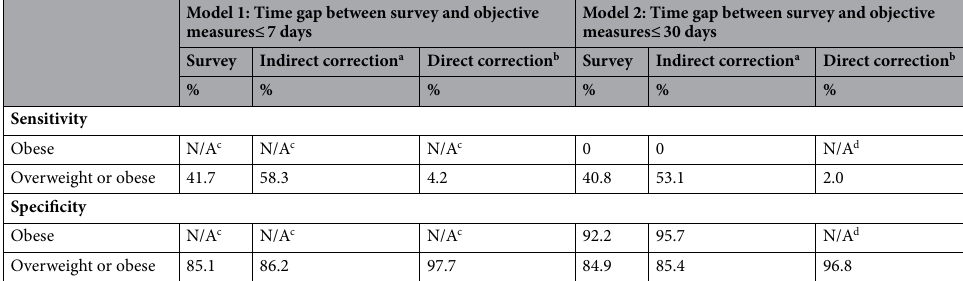
Height ( cm ) = − 419.150 + 0.263 × Height MR ( cm ) + 39.28 × month − 0.799 ∗ month 2 + N ( 0, 3.209 ) Weight (cid:31) kg (cid:30) = 3.097 + 0.765 × Weight MR (cid:31) kg (cid:30) − 0.282 × mother bornoverseas + N ( 0, 0.965 )